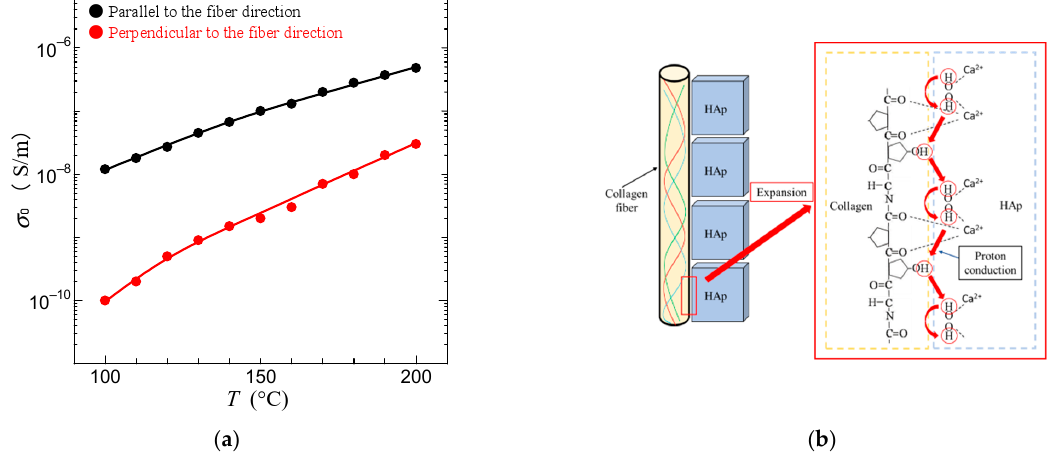
Figure 1. Temperature dependence of proton conductivity parallel to the fiber direction and perpendicular to the fiber direction ( a ) and proton conductivity pathway in the Hap–collagen composite ( b ).